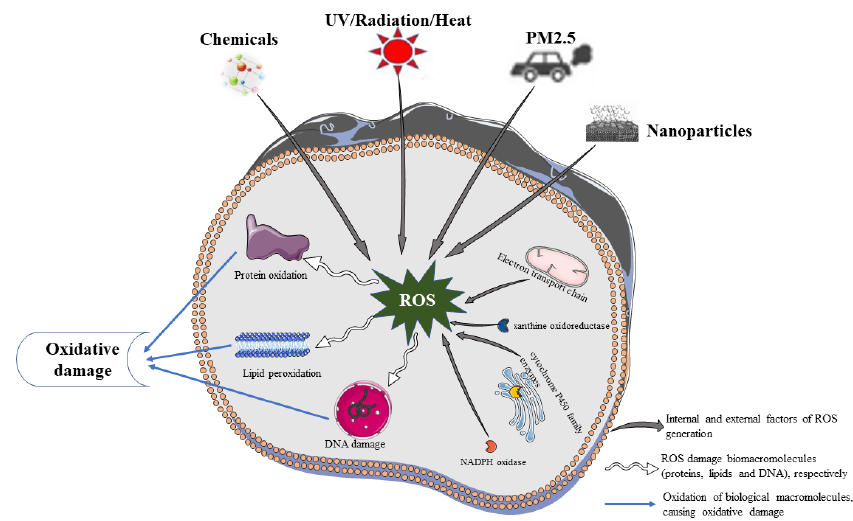
Figure 1. Oxidative damage of biological macromolecules.